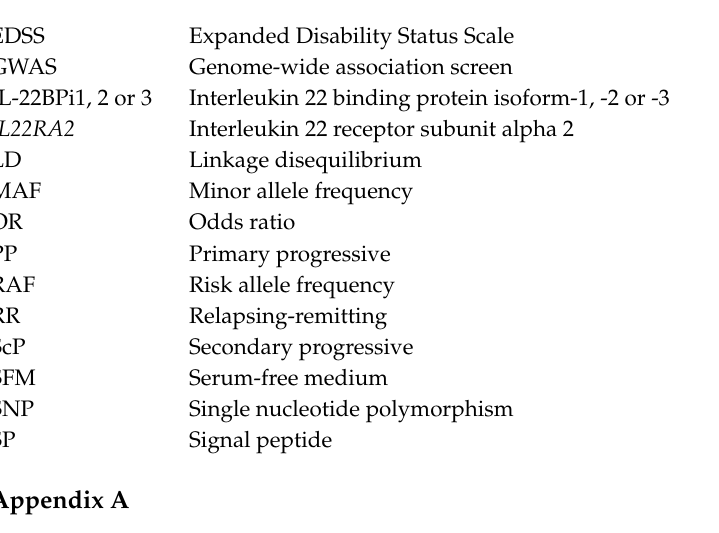
Table A1. Association values of all SNPs included in the fine mapping conditioned to the index SNP,